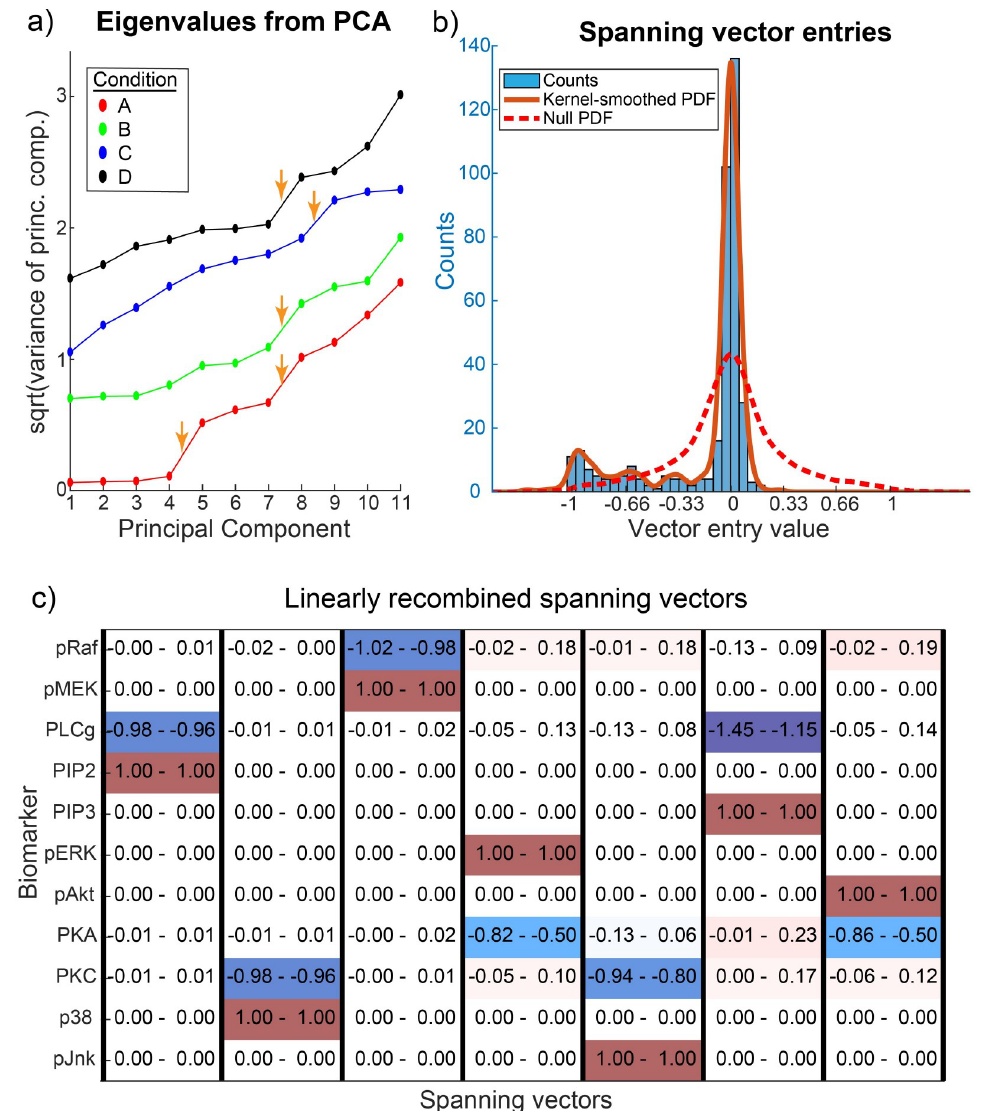
Fig 4. Peculiar properties of single-cell high-dimensional datasets (FACS). (a) Eigenvalue spectra from PCA of the larger CD4+ subpopulations are shown for 4 of the 13 conditions (shifted to avoid overlap). Apparent gaps denoted by orange arrows. (b) The small eigenvectors were linearly recombined by row reduction on their transpose, with complete pivoting, for ease of interpretation. The distribution of the linearly recombined entries from all 13 conditions are shown in a histogram (not including the 0s and 1s that are necessarily produced by row reduction), as well as with a Gaussian smoothing kernel of bandwidth 0.04. Peaks seem to appear at -1/3, -2/3, and -1. The null distribution for random, sparse, constraints is also shown for comparison. (c) As an example, the recombined vectors for Condition A are shown, with bootstrapped 95% confidence intervals. Other conditions are similar in